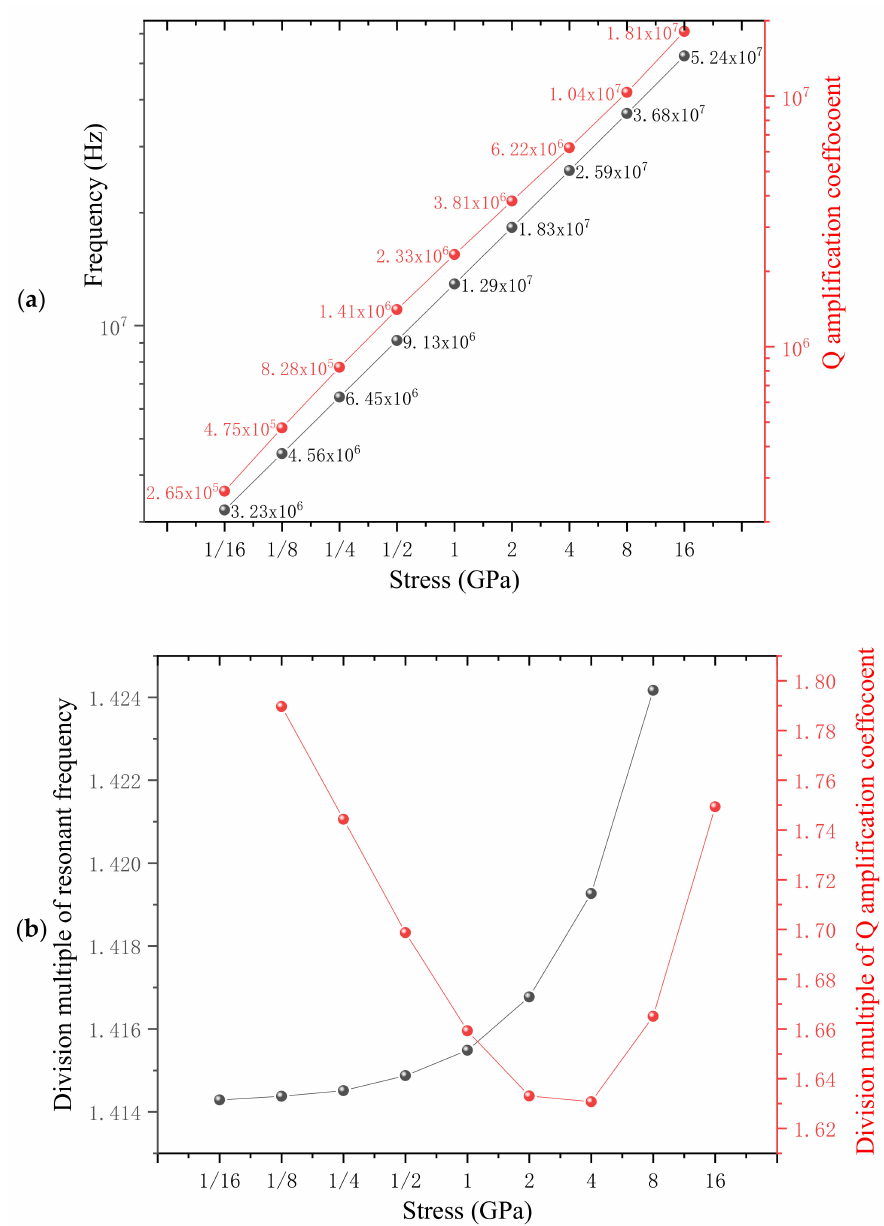
Figure 8. ( a ), The relationship between the stress and Q amplification coefficient along with the resonant frequency both in the form of logarithmic coordinates. ( b ) Division multiples between adjacent two resonance frequencies as well as Q amplification